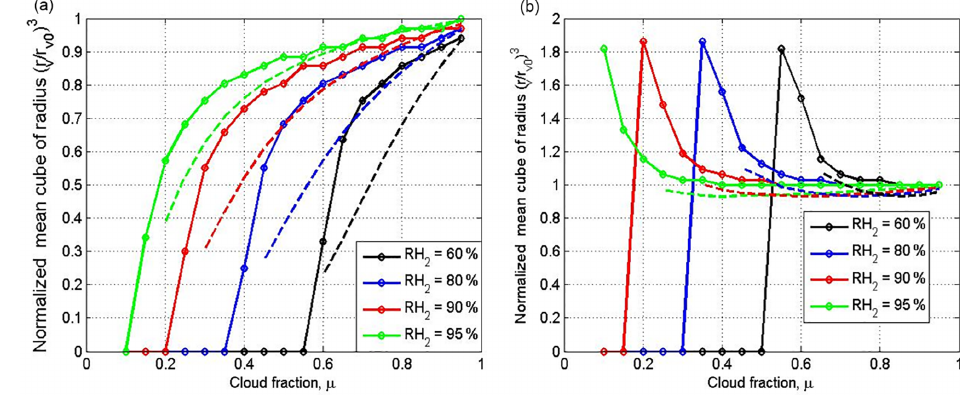
Figure 9. Mixing diagrams. Normalized cube of the mean volume radius vs. the cloud fraction for initial narrow DSD (a) and initial wide DSD (b) . The dependencies correspond to the equilibrium state. Parameters of initial DSD are presented in Table 1. Solid and dashed lines show the mixing diagrams for inhomogeneous and homogeneous mixing, respectively. The initial mixing parameters are T = 10 ◦ C, p = 828.8mb and L = 40m.